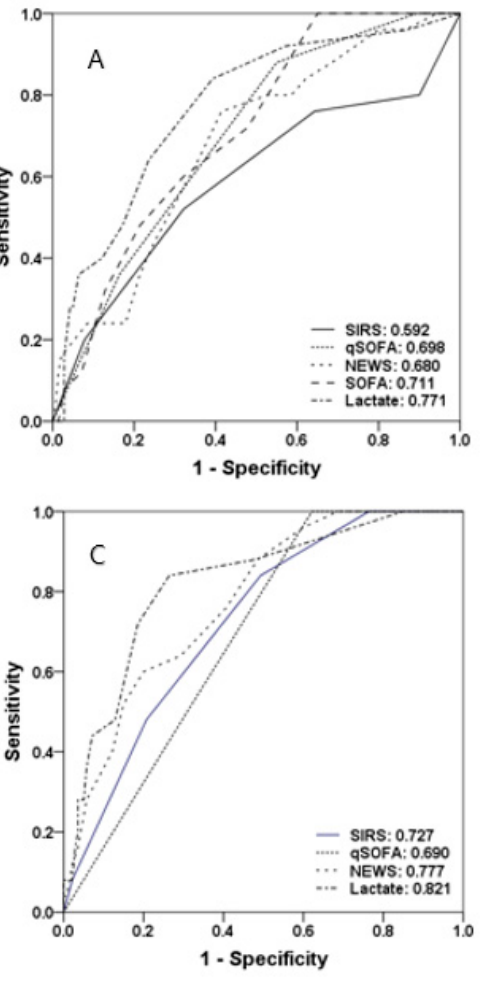
Figure 4. Areas under receiver operating characteristic curves for the prediction of in-hospital mortality, application of mechanical ventilation, and admission to the ICU of the SIRS score, qSOFA score, NEWS, SOFA score, and lactate levels across four timepoints (triage ( A ), fluid resuscitation ( B ), start vasopressor ( C ), and before leaving the ER ( D )). ICU, intensive care unit; SIRS, systemic inflammatory response syndrome; SOFA, Sequential Organ Failure Assessment; qSOFA, quick SOFA; NEWS, National Early Warning Score.